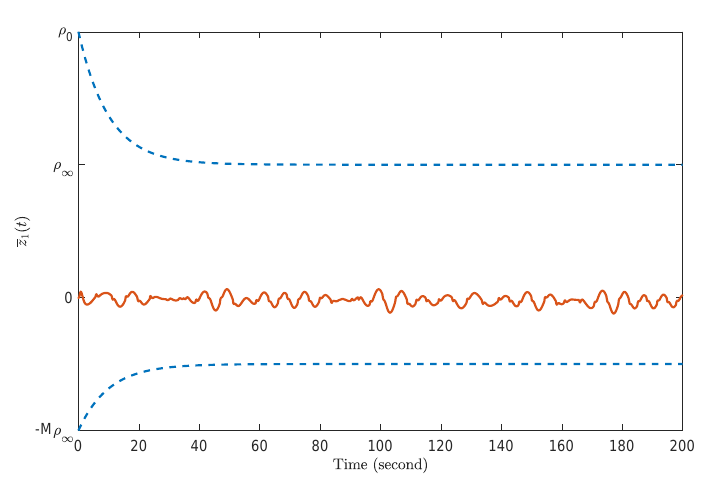
Figure 4. The value of the disturbance observer.